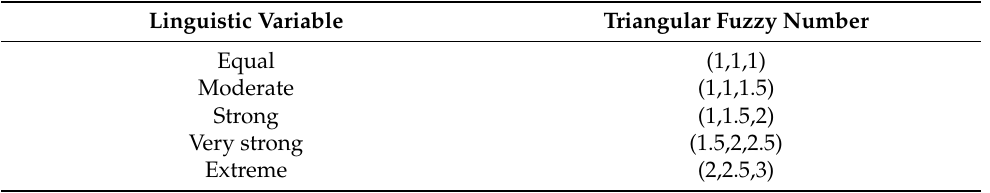
Table 1. Linguistic variables for rating the risk factors.